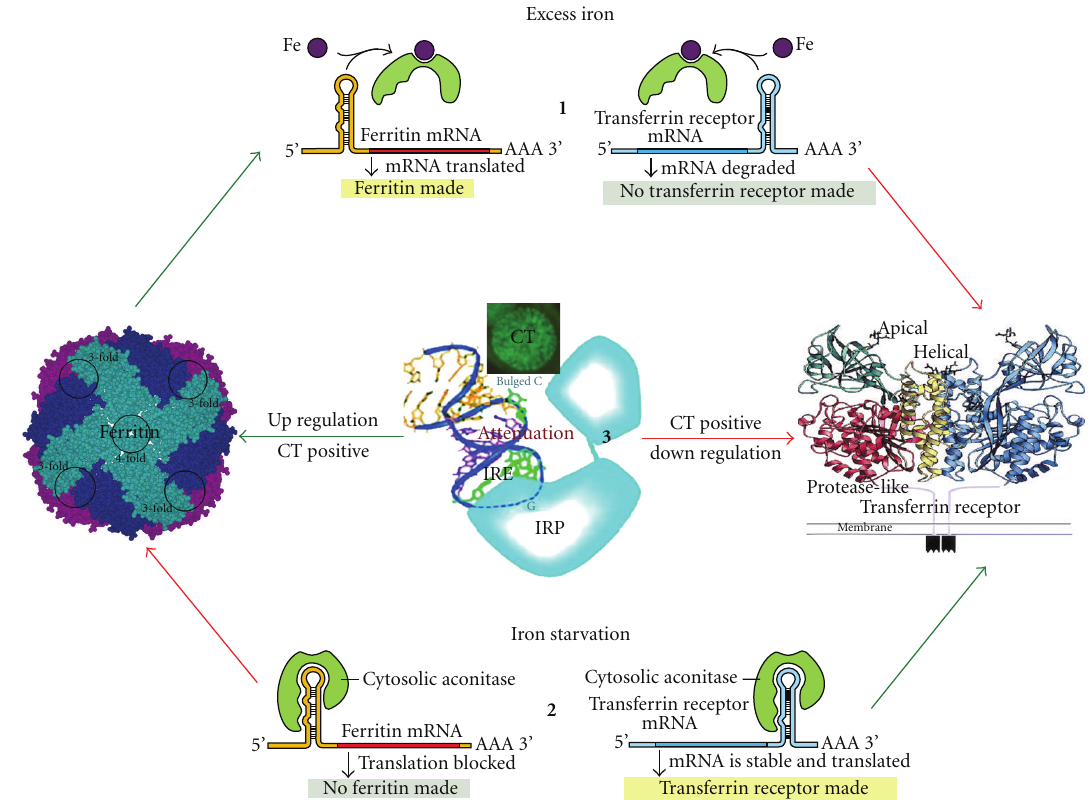
Figure 4: Translational initiation of ferritin and TfR mRNA degradation are regulated by binding of IRP to IRE in response to availability of iron. (1) In the excess iron, IRP forms an open conformation and is not able to bind IRE, subsequently translation of ferritin gets initiated and degradation of exposed TfR mRNA takes place. (2) In iron starved cells, IRP attains a closed conformation and binds to IRE present on 5 (cid:3) UTR of ferritin mRNA thus interferes with translation initiation and simultaneously stabilize TfR mRNA by binding 3 (cid:3) UTR. (3) Binding a ffi nity of IRP-IRE is attenuated in presence of chlamydia leading to lower expression of TfR and higher expression of FHC [27].